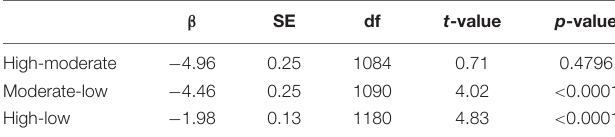
TABLE 2 | Linear regression analysis adjusted testing the differences between measurements of frequency octave band slopes between sites (high, moderate, and low levels of